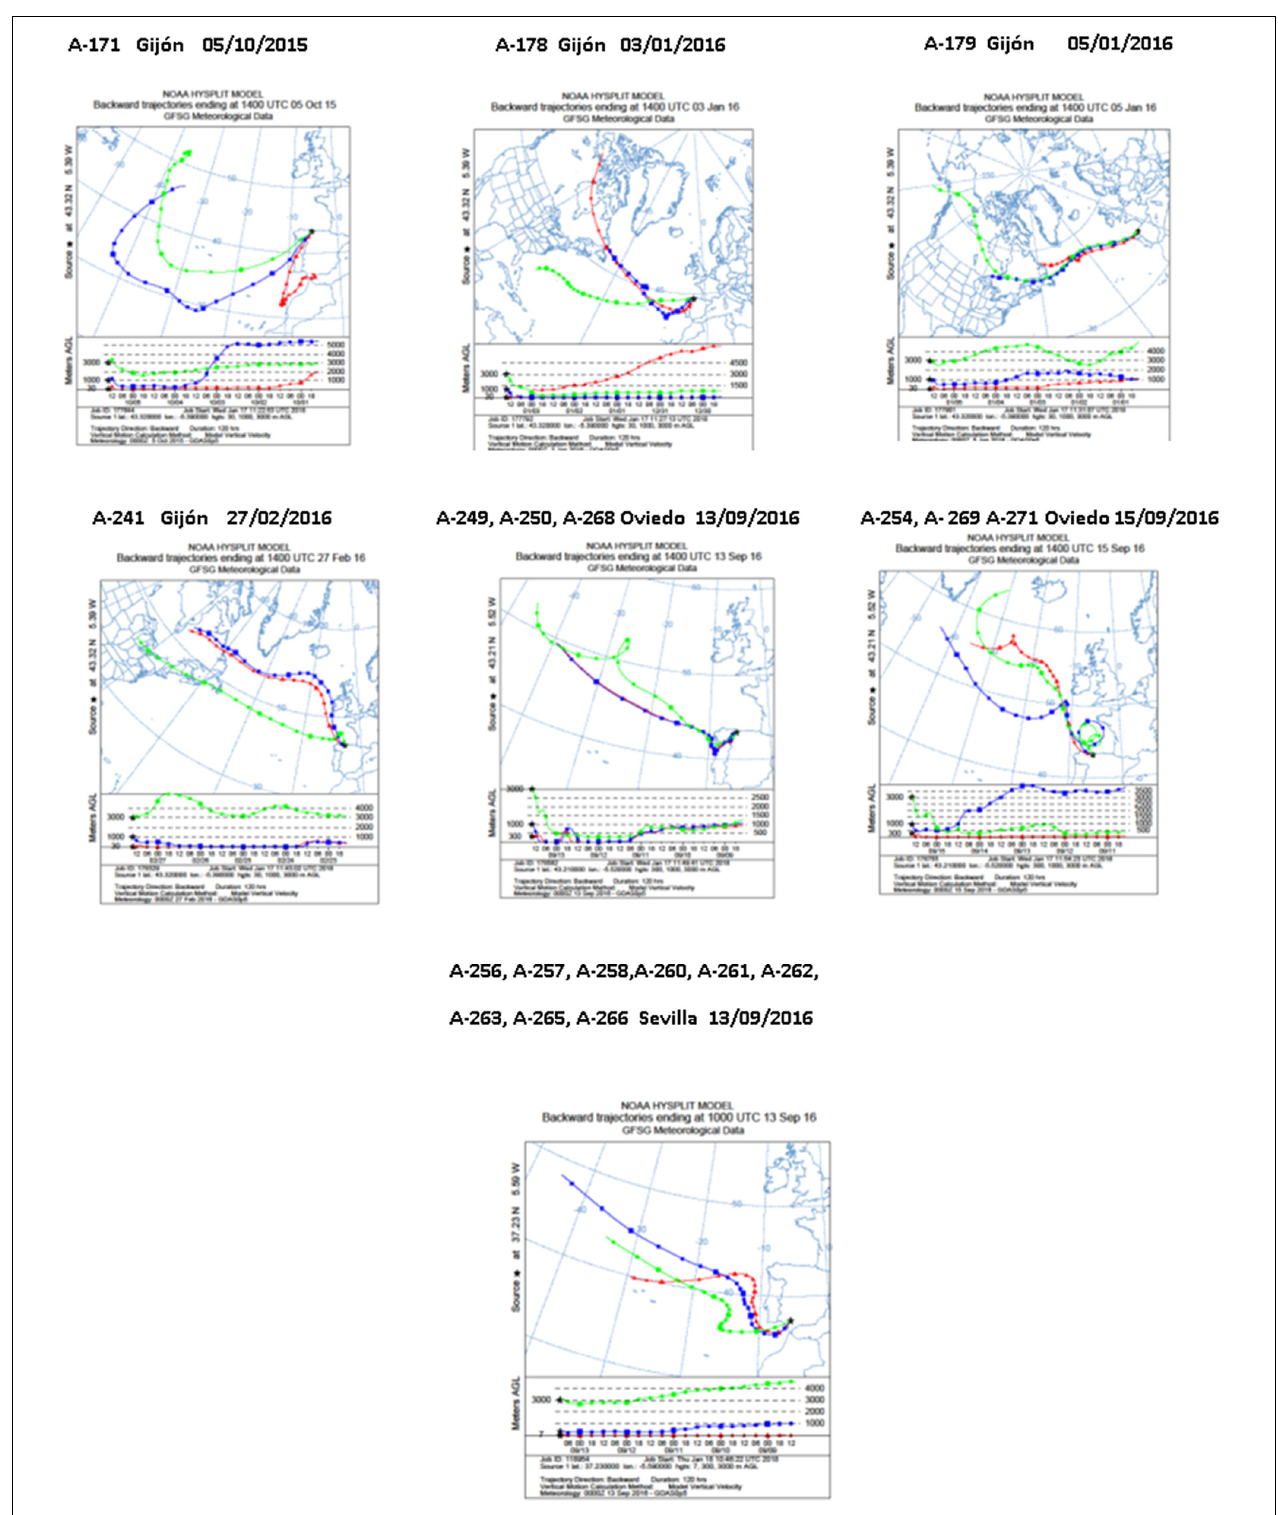
FIGURE 3 | Five-day backward trajectories of air masses generating the storms that arrived at Spain and caused the diverse precipitation events. They were calculated with the NOAA HYSPLIT Model with three different transects with different arriving height as previously reported (Sarmiento-Vizcaíno et al., 2018). The sampling locations were used as the backward trajectory start point with altitudes over sea level of 30, 1,000, and 3,000 m (Gijón), 300, 1,000, and 3,000 m (Oviedo), and 7, 1,000, and 3,000 m (Seville). Sampling places are indicated by the black asterisks.